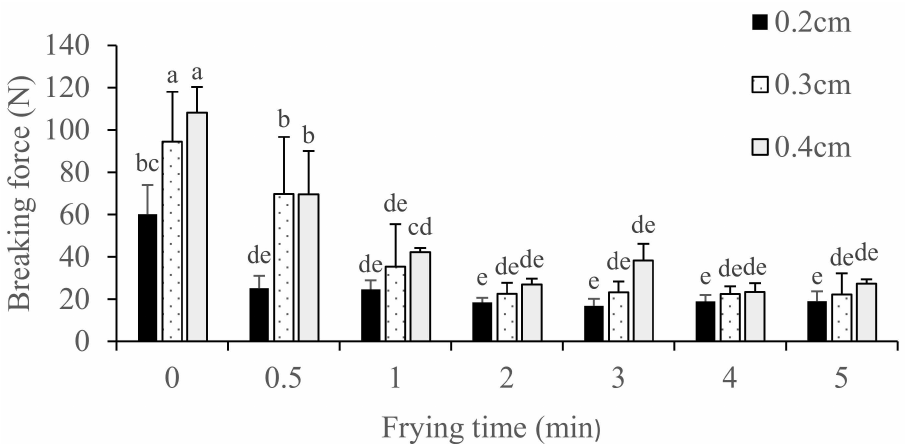
Figure 3. Changes on breaking force of fried pork rind with different thickness and frying time.